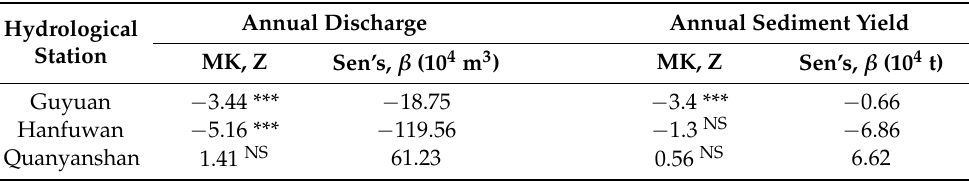
Table 2. Results of trends in annual discharge and annual sediment yield from 1960 to 2016 based on the MK test. Hydrological